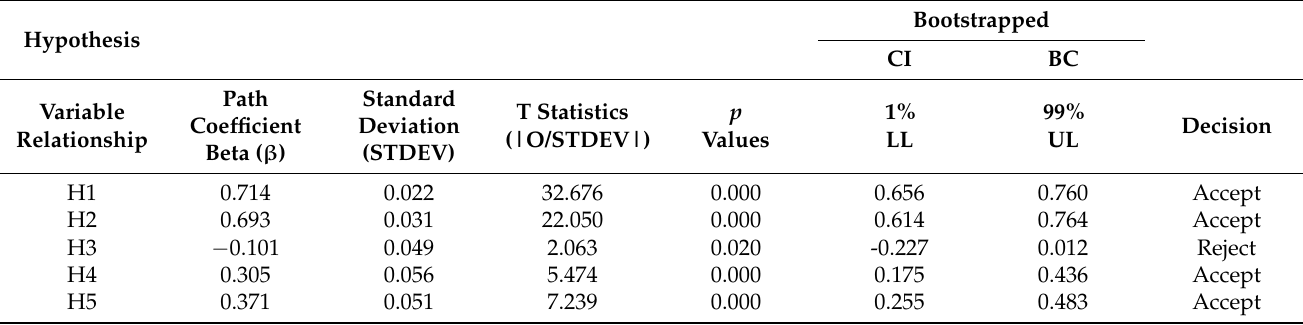
Table 6. Direct Effect Hypotheses.